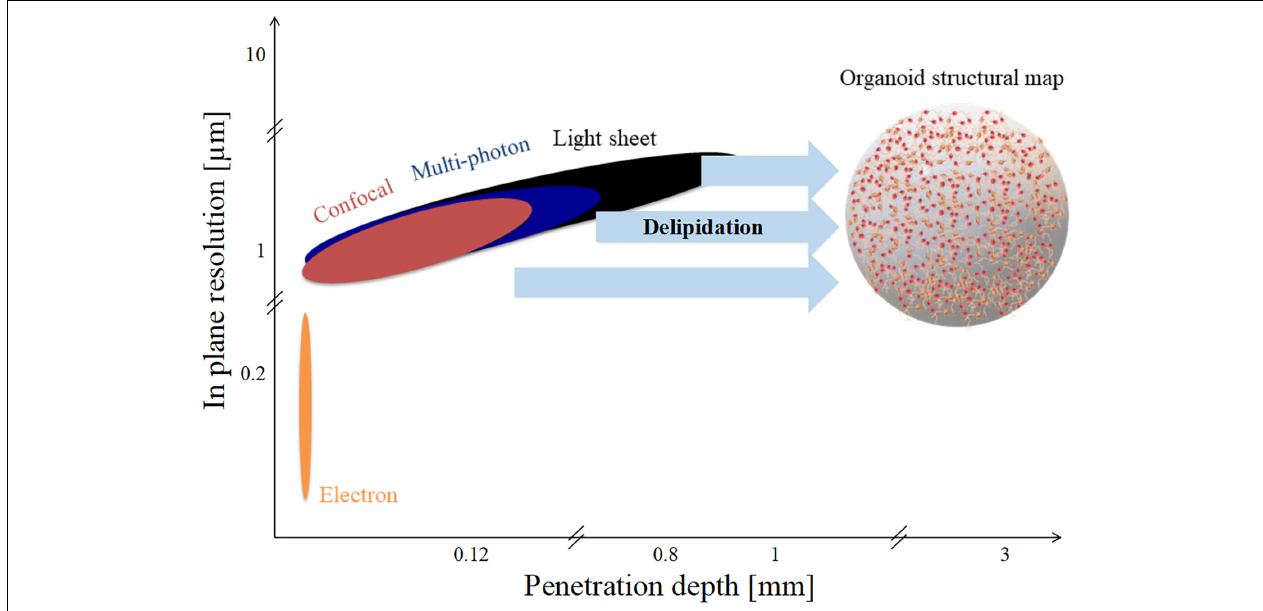
FIGURE 4 | Spatial limits of modern imaging techniques applied to brain organoids. Penetration depth and in-plane resolution of specific techniques such as confocal, multi-photon, and light sheet microscopy. Delipidation increases light penetration depth but not in-plane resolution.